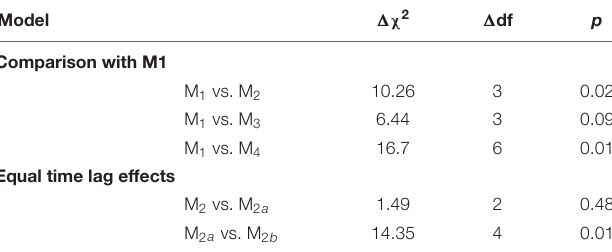
TABLE 4 | Chi-square difference tests of competing